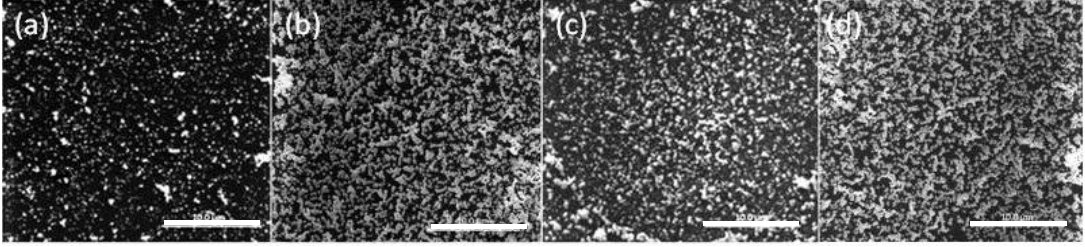
Figure 4. SEM images of the surface of the PIM corresponding to Au(III) extraction times of ( a ) 8 h; ( b ) 12 h; ( c ) 12.5 h; and ( d ) 79 h. The PIM loaded with Au(III) was exposed to 0.10 mol·L −1 ethylenediaminetetraacetate (EDTA) at pH 6.0 for 24 h. The white bars are equal to 10 μm.